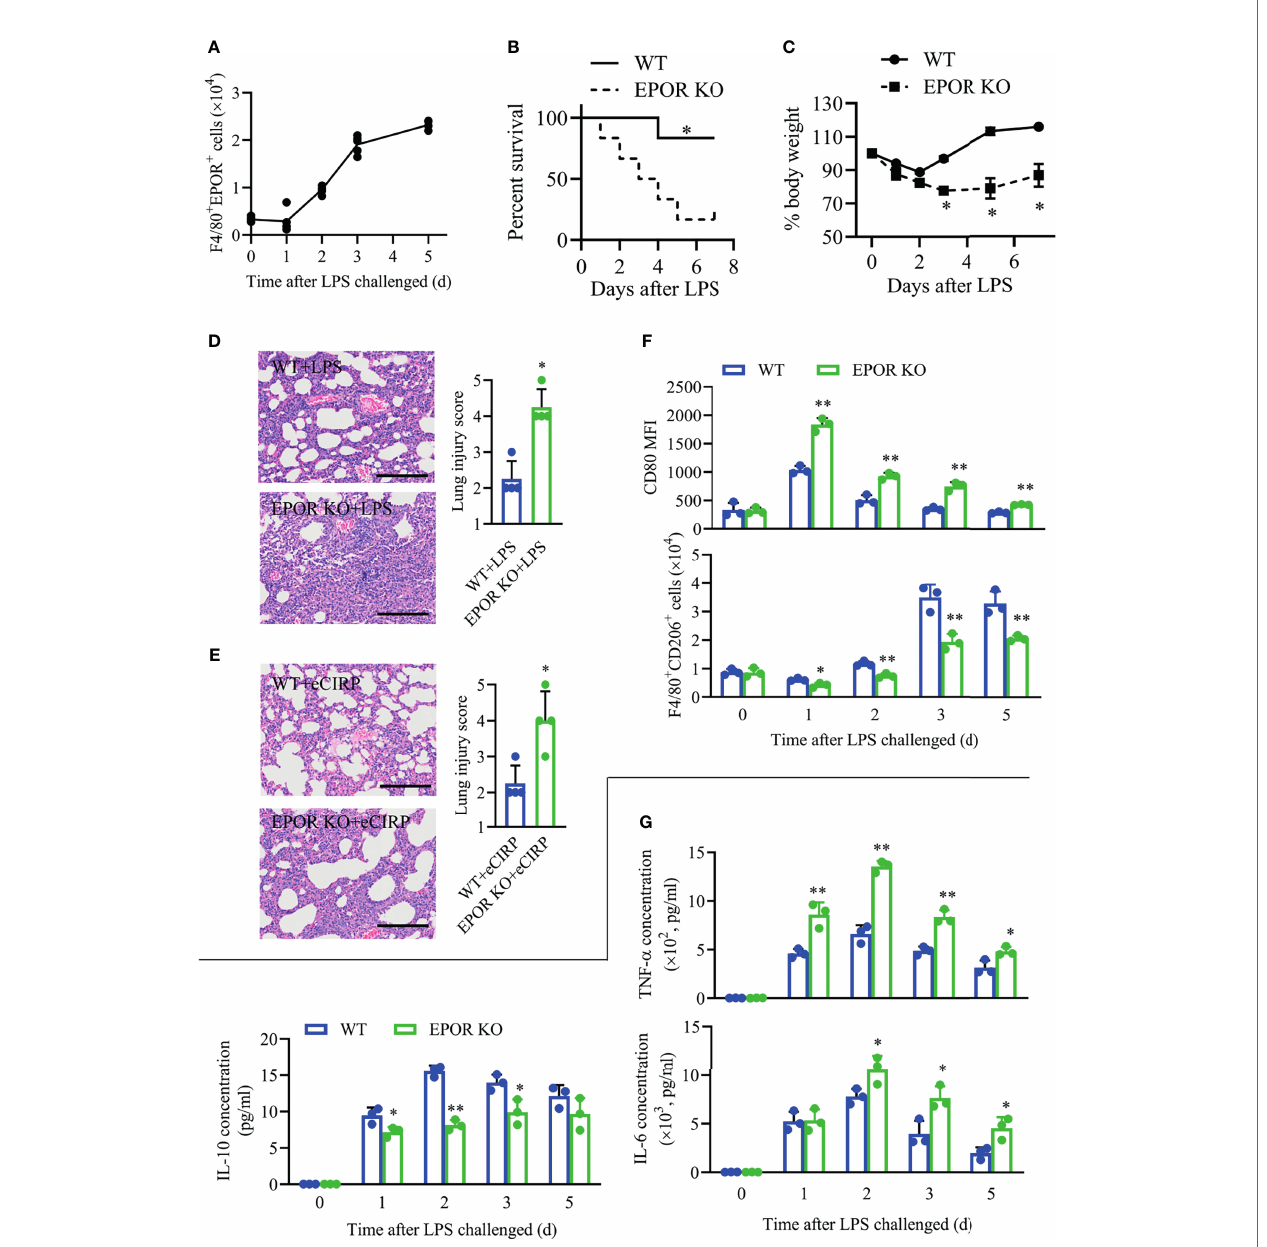
FIGURE 3 | Myeloid EPOR de fi ciency aggravates in fl ammation in lung injury. (A) WT mice (n = 5) were treated with 3 mg/kg LPS (i.t.) at the indicated times (days 0, 1, 2, 3, and 5). The number of F4/80 + EPOR + macrophages in BALF was measured by FACS. (B) EPOR cKO and WT mice were challenged with 10 mg/kg LPS i.t., and survival was monitored (n = 6). (C) EPOR cKO and WT mice were treated with 3 mg/kg LPS (i.t.) at the indicated times. Change in body weight was monitored over 6 days (n = 4). (D) Lung tissue samples from mice with LPS administration for 48 h were dissected and subjected to H&E staining. Lung injury scores in each group were analyzed (n = 4). Scale bar: 150 µm. (E) EPOR cKO and WT mice were treated with 1 mg/kg eCIRP (i.t.). Lung tissue samples from mice with eCIRP administration for 48 h were dissected and subjected to H&E staining. Lung injury scores in each group were analyzed (n = 4). Scale bar: 150 µm. WT and EPOR cKO mice were treated with 3 mg/kg LPS (i.t.) at the indicated times (days 0, 1, 2, 3, and 5). (F) The MFI of CD80 and the percentage of CD206 + cells in BALF macrophages were measured by FACS at the indicated time (n = 3). (G) The concentrations of TNF- a , IL-6, and IL-10 in BALF at the indicated time was measured (n = 3). Data are representative of at least two independent experiments. Results were expressed as mean ± SD. * P < 0.05, ** P < 0.01 compared to the WT group at indicated time. Statistics: Log-rank test (B) or unpaired two-tailed Student ’ s t-test (C – G) . EPOR, erythropoietin receptor; LPS, lipopolysaccharide; eCIRP, extracellular cold-inducible RNA-binding protein; WT, wild type; BALF, bronchoalveolar lavage fl uid; MFI, mean fl uorescence intensity; FACS, fl uorescence activated cell